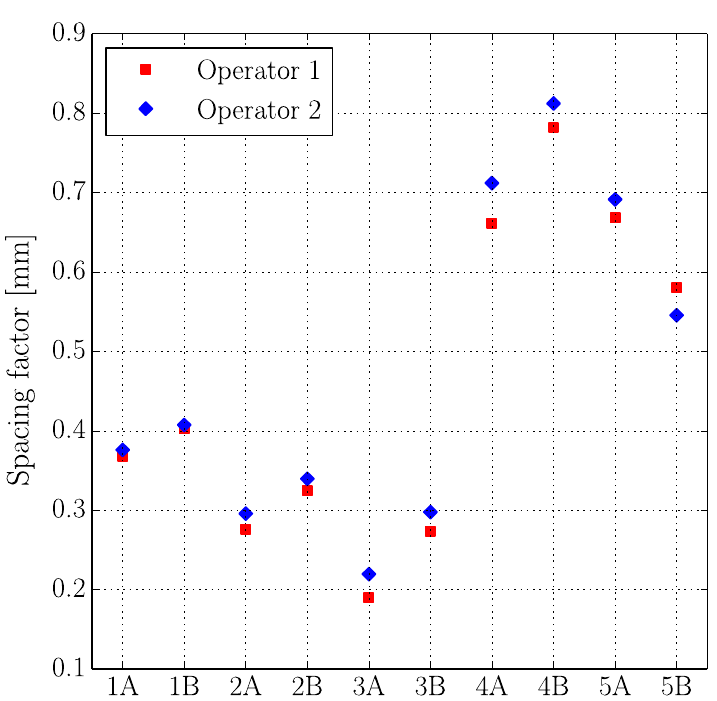
Figure 8. Results of the spacing factor of the slabs studied by two distinct operators.